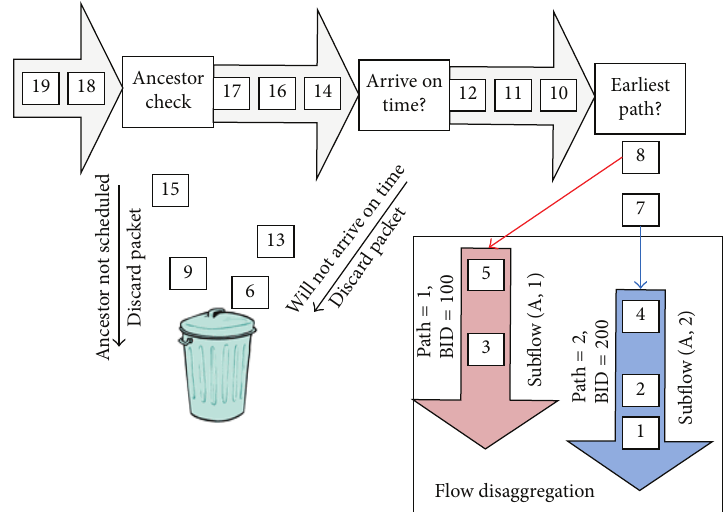
Figure 7: The flow of packets through the path selection and packet scheduling subsystem.